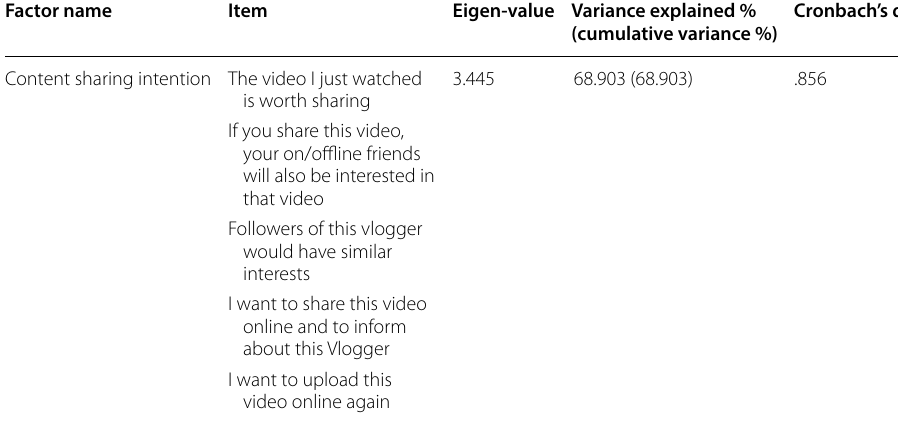
Table 2 The result of principal factor analysis for content sharing intention Factor name